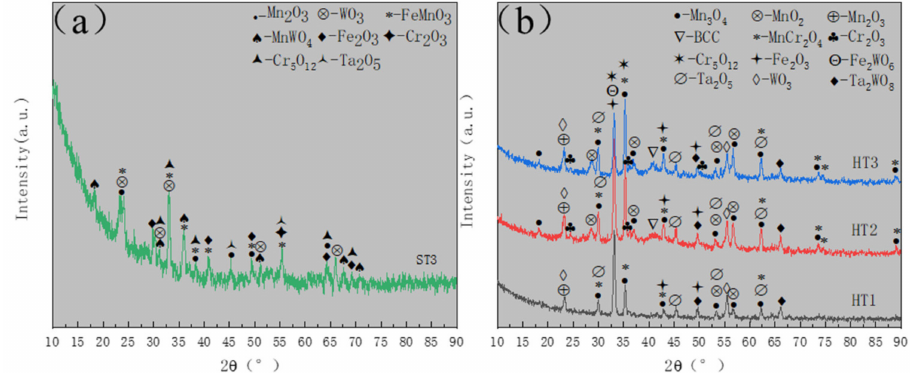
Figure 6. ( a ) The GIXRD pattern of ST3, i.e., Cr 20 Mn 17 Fe 18 Ta 23 W 22 RHEA oxidized at 800 ◦ C (6.7 ◦ C/min) for 4 h (Ar:O 2 = 3:1); ( b ) The GIXRD results of HT1, HT2 and HT3,